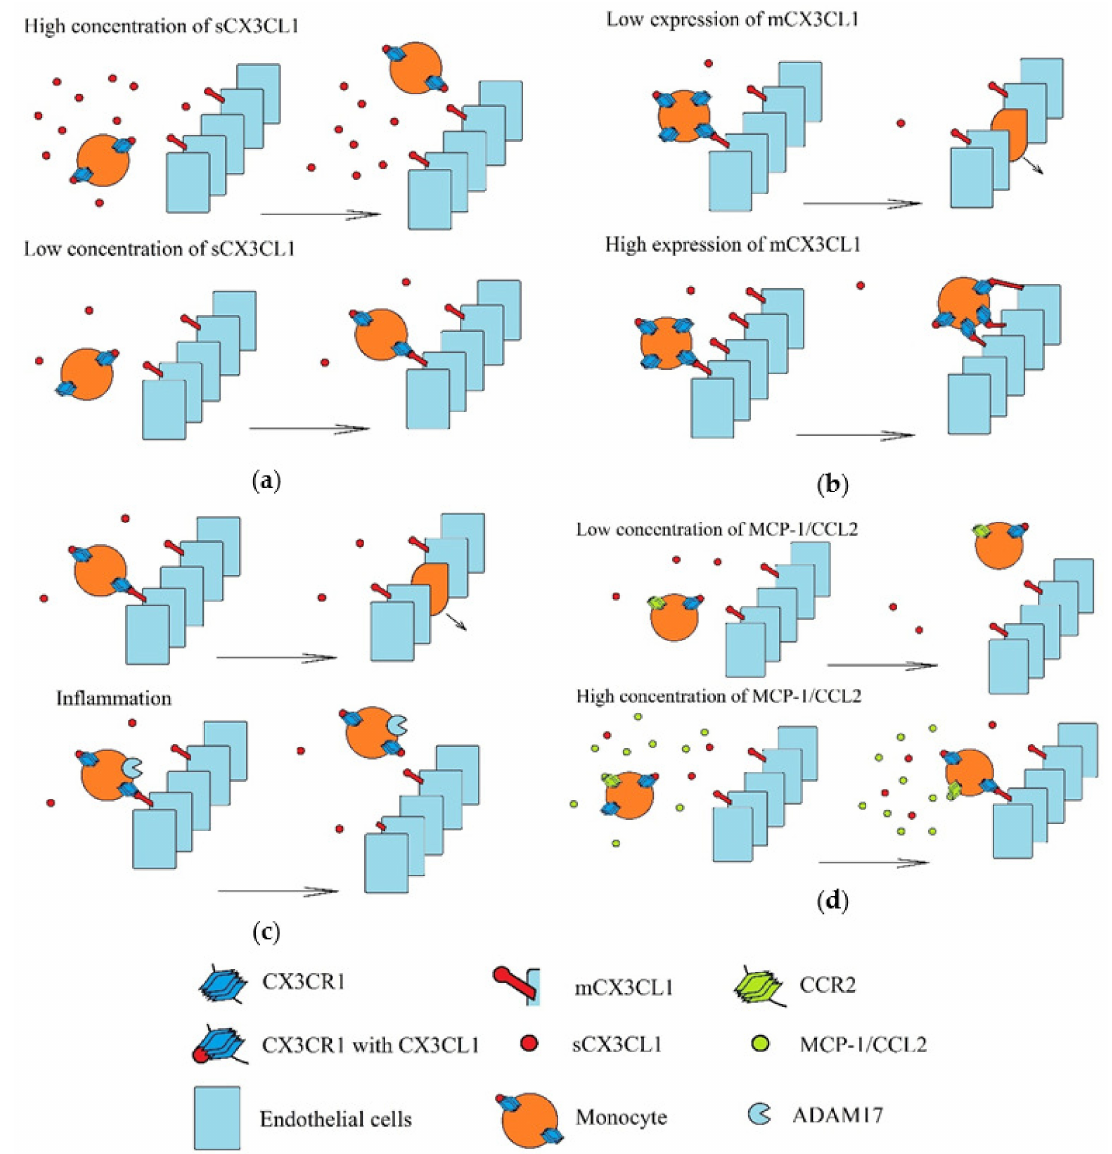
Figure 5. Recruitment of monocytes in various environments. Monocytes are recruited via mCX3CL1-dependent adhesion to vascular walls and transendothelial migration. These processes depend on: ( a ) the concentration of sCX3CL1. A high concentration of this chemokine activates all CX3CR1 and it can no longer bind more CX3CL1, including mCX3CL1. ( b ) Concentrations of mCX3CL1 on the vascular walls. A high concentration of mCX3CL1 causes very strong monocyte adhesion, which causes retention of these cells on the vascular walls and inhibit transendothelial migration of monocytes. ( c ) Inflammatory processes induced in recruited monocytes, in particular the level of TACE / ADAM17 activity. Inflammatory reactions increase the production of TNF- α and TACE / ADAM17 (an enzyme that releases this pro-inflammatory cytokine). However, this metalloproteinase also cleaves mCX3CL1. This results in the releases of sCX3CL1, and hence, reduces the amount of mCX3CL1 on the walls of the blood vessels. ( d ) Concentrations of other chemokines, in particular MCP-1 / CCL2. Activation of MCP-1 / CCL2 receptor (CCR2) causes increase CX3CR1-dependent monocyte adhesion. Inflammatory reactions increase mCX3CL1 levels on endothelial cells [18,30–33]. This leads to the adhesion of non-classical monocytes to vessel walls near the tumor [18], followed by the production of IL-6, MCP-1 / CCL2 and MMP-9 by monocytes [205]. However, the high levels of mCX3CL1 do not allow trans-endothelial migration of these monocytes, and thus, their retention occurs on